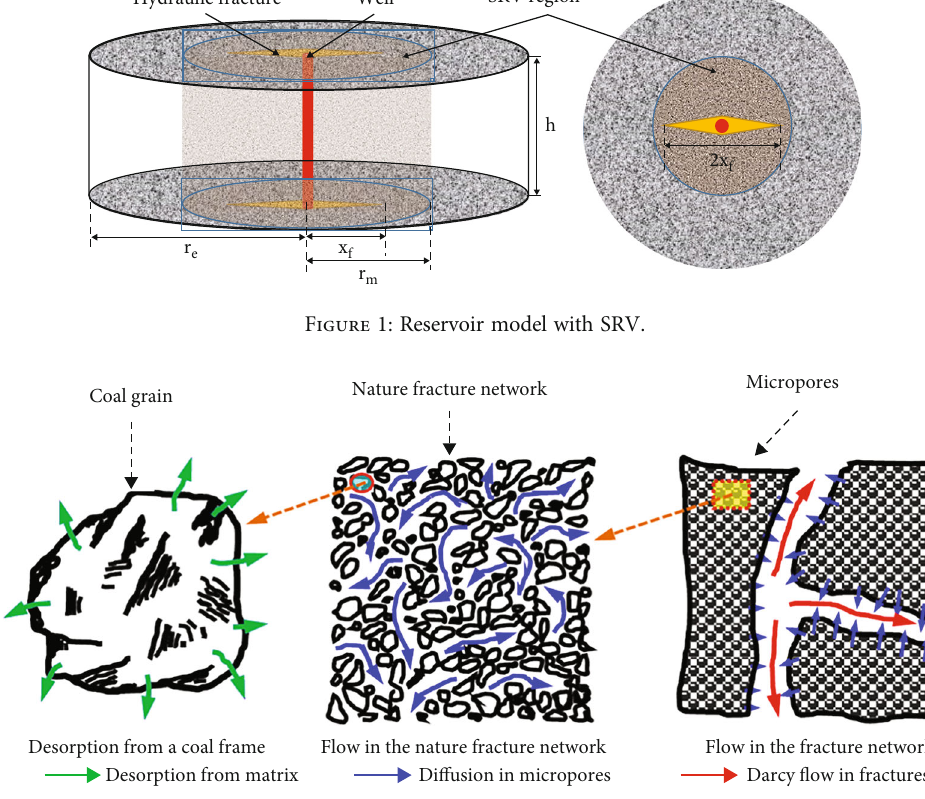
Figure 2: Desorption and di ff usion in the matrix and Darcy fl ow in the fracture.